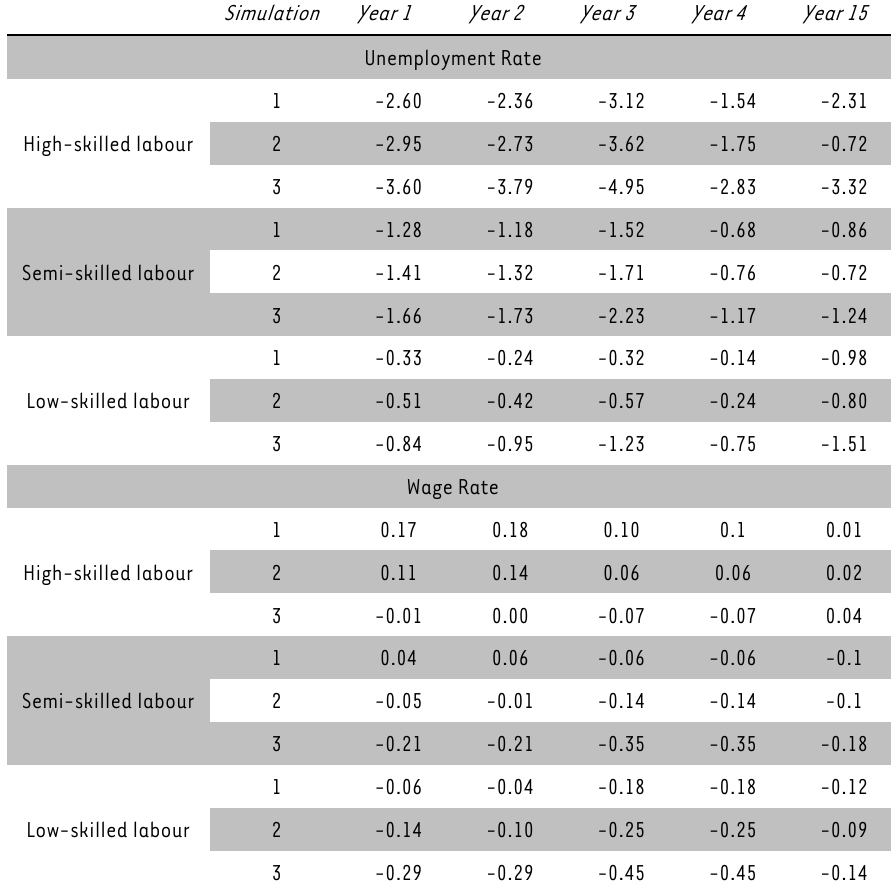
TABLE 3: Changes in wage rate and unemployment rate, formal labour (% change from BAU)